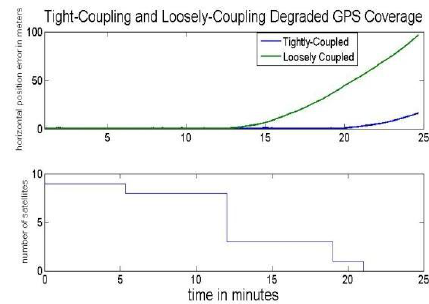
Figure 4 The comparison between TC and LC architectures with variable number of visible satellite